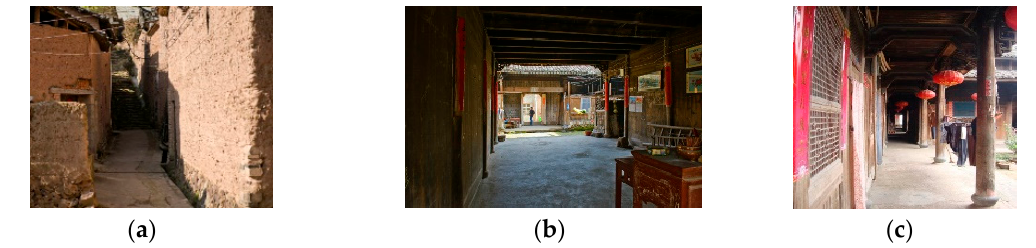
Figure 5. Floor plans of typical dwellings in ( a ) Heyang and ( b ) Danzhi.